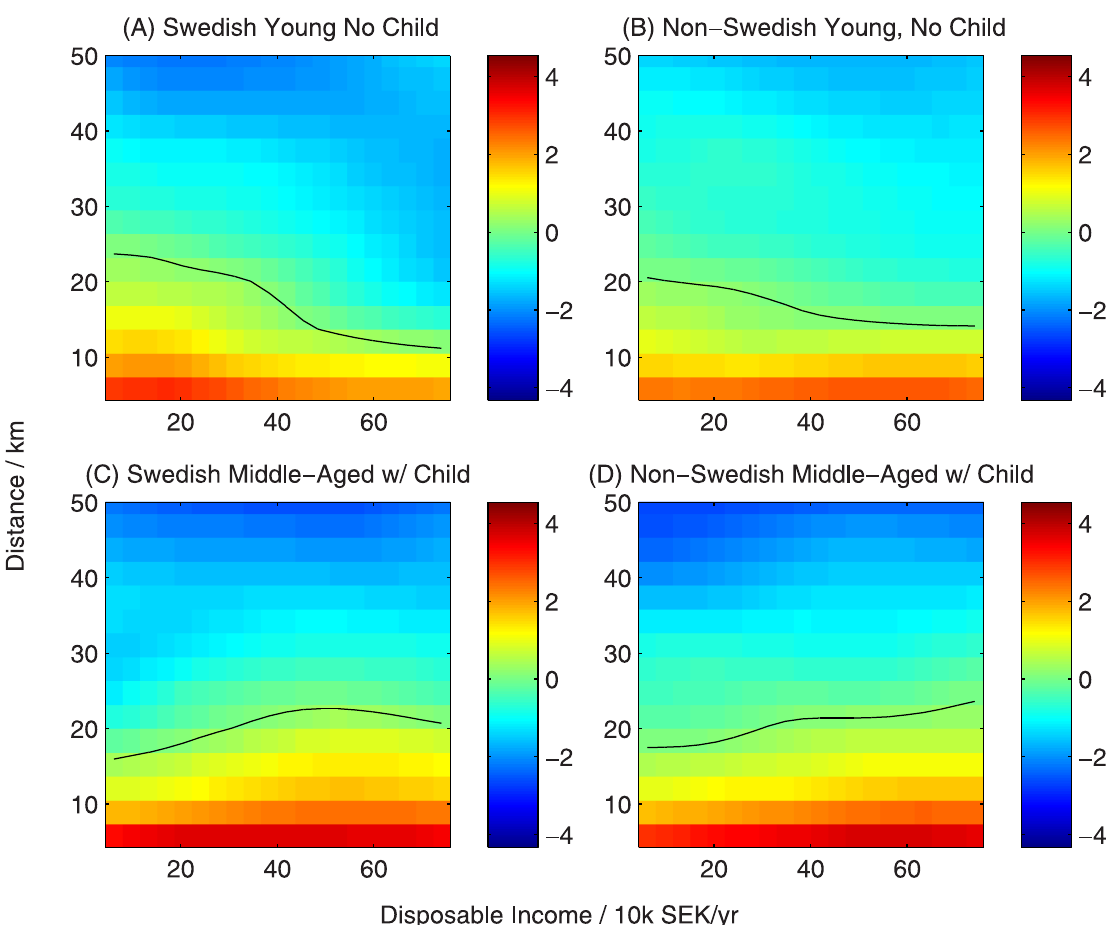
Fig 2. Utility function for neighbourhood distance from the household’s current abode. Black contours represent a utility of zero, indicating no overall preference for or against neighbourhoods with this characteristic. Candidate neighbourhood distances extend to 50 kilometres, within the Stockholm urban